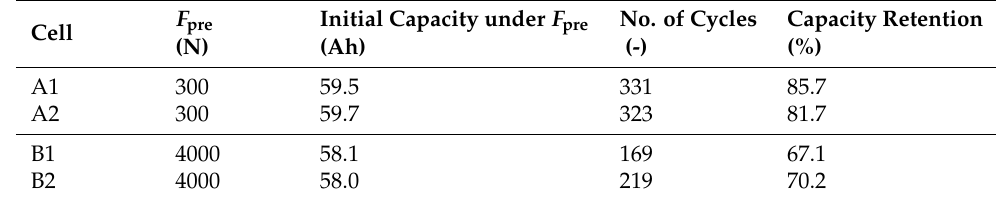
Figure 7. ( a ) Capacity retention over energy throughput during the aging procedure. ( b ) Irreversible thickness increase over energy throughput during the aging procedure. Table 2. Capacity retention of pouch cells after the aging